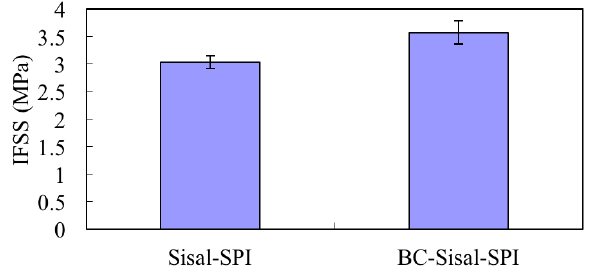
Figure 4. Interfacial shear strength (IFSS) of BC/SPI and BC-sisal/SPI using microbond tests.